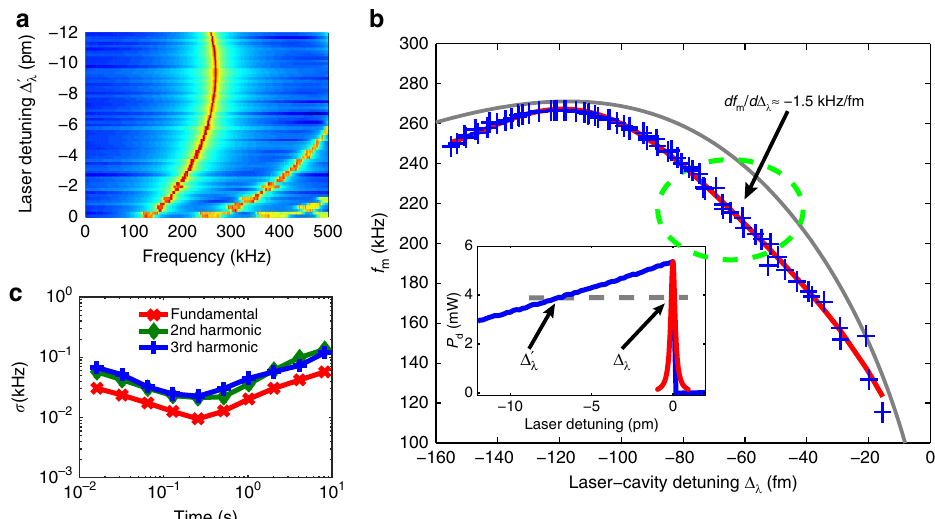
Figure 2 | OMO versus laser-cavity detuning. ( a ) Spectrogram of cavity transmitted signal as a function of laser wavelength detuning D 0 l (see Fig. 1d for the meaning of D 0 l ), showing the detuning-dependent mechanical frequency. The proportional frequency variations at the second and third harmonics are clearly visible. Every spectrum was averaged over five traces acquired continuously. ( b ) The OMO frequency as a function of laser-cavity wavelength detuning. The blue crosses show the experimental data and the grey curve shows the theory. The red curve is a polynomial fitting to the experimental data. The dashed circle indicates the operating regime for the particle and molecule sensing, with a frequency tuning slope of df m / d D l ¼ (cid:3) 1.5kHzfm (cid:3) 1 at a laser-cavity detuning of D l ¼ (cid:3) 70fm. Inset: recorded optical power as a function of laser wavelength detuning. This curve was used to obtain the real laser-cavity wavelength detuning. ( c ) The two-sample Allan deviations of the fundamental, second and third harmonic tones measured in DPBS in the absence of sensing particle, showing a minimum deviation of 9.5Hz at the fundamental oscillation